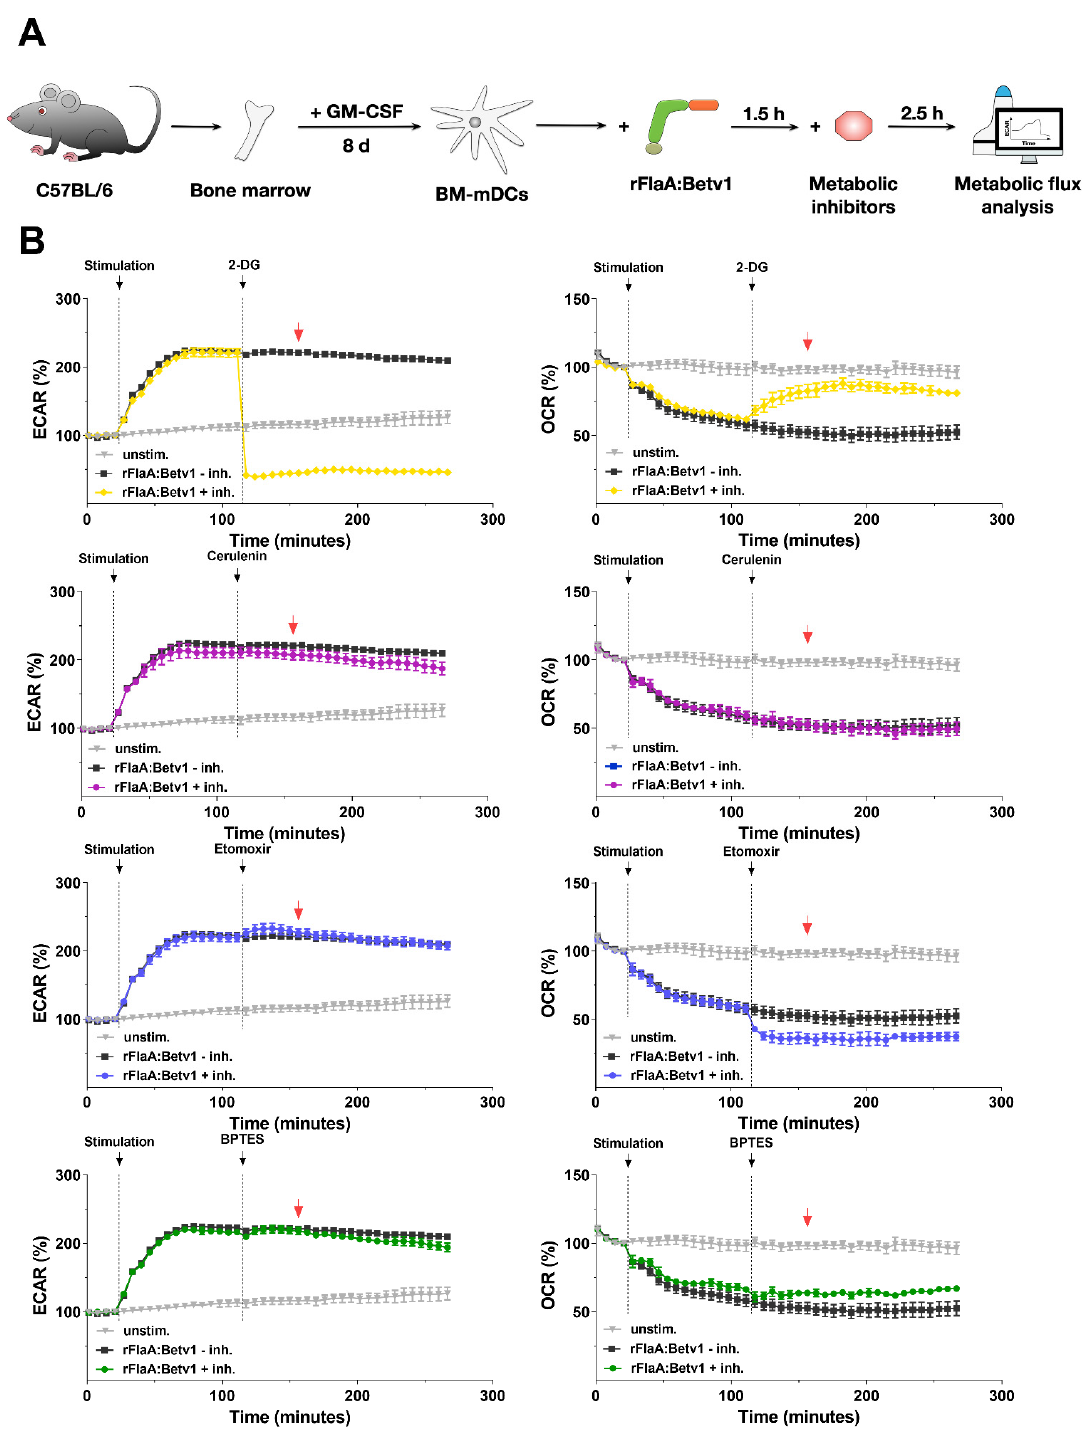
Figure 2. The rFlaA:Betv1-induced increase in ECAR depends on glucose metabolism. mDCs were stimulated with 11 µ g/mL rFlaA:Betv1 for 14 cycles (84 min) followed by injection of the different inhibitors (2-DG: 50 mM, cerulenin: 2 µ g/mL, etomoxir: 100 µ M, BPTES: 20 µ M) for another 24 cycles (144 min) and continuously analyzed for extracellular acidification rates (ECAR) and oxygen consumption rates (OCR) using Seahorse technology ( A ). Data are representative results of three independent experiments that showed similar results, with three to four technical replicates per experiment ( B ). The red arrow indicates the time point chosen for statistical analysis shown in Repos. Figure S5 (for more information, see